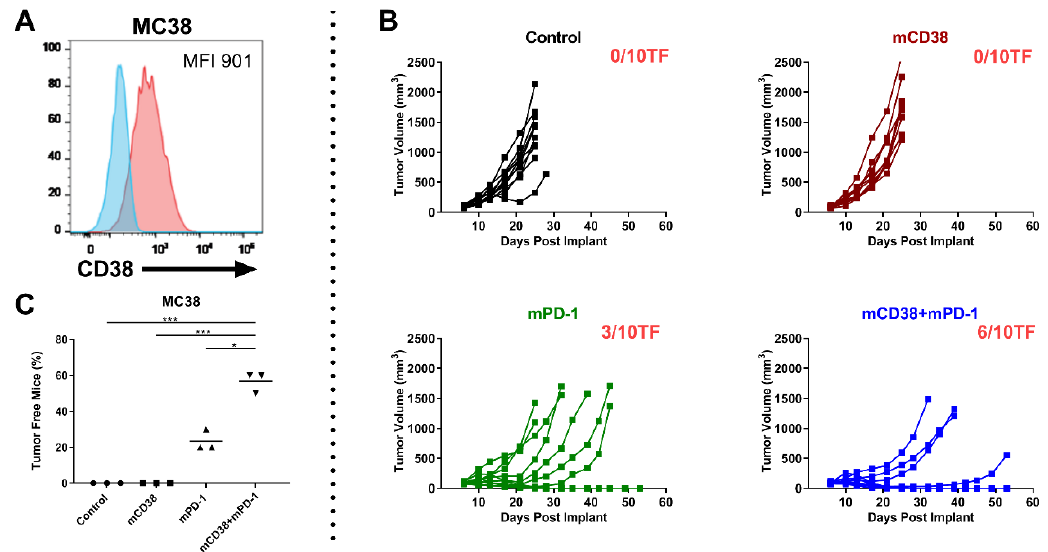
Figure 5. Combination of anti-mCD38 and anti-mPD-1 show enhanced antitumor activity in a CD38- expressing MC38 tumor model. ( A ) A representative flow cytometry histogram overlay, depicting CD38 cell surface expression on MC38 colon carcinoma cells (red histogram), compared with the isotype control (blue histogram). The median fluorescence intensity (MFI) is provided. ( B ) C57BL / 6 mice were injected subcutaneously with MC38 tumor cells (1 × 10 6 cells) and randomized at day 6 when their tumors reached an average size of 80–100 mm 3 . Mice were injected intraperitoneally with 10 mg / kg of either control mIgG2a, anti-mCD38 mAb, anti-mPD-1, or combination of anti-mCD38 / anti-mPD-1 mAbs on days 6, 10, 13, 17, and 20. Tumor volumes for individual mice and the number of tumor-free mice per group are shown; n = 10 per group. This experiment is representative of a total of three independent experiments. ( C ) Fisher’s Exact test (two-sided) was used to determine the between-treatment differences in the proportion of MC38-bearing mice that were tumor free. Three independent tumor studies were performed with 10 mice per treatment per study. Symbols represent different studies within a treatment group. Abbreviations: * p ≤ 0.05, *** p ≤ 0.001.